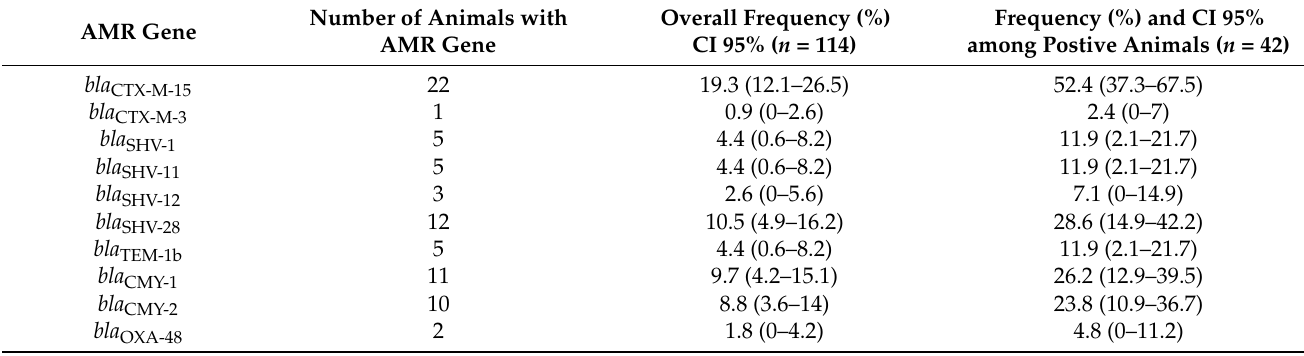
Table 1. Number and frequencies of the samples positive for β -lactamase genes in European hedgehogs. CI, confidence